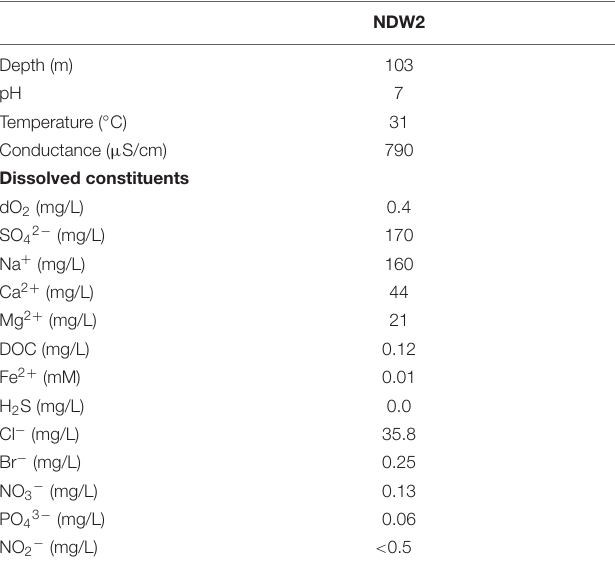
TABLE 1 | Chemical composition of water collected from Nevares Deep Well 2 (Death Valley, CA, USA).